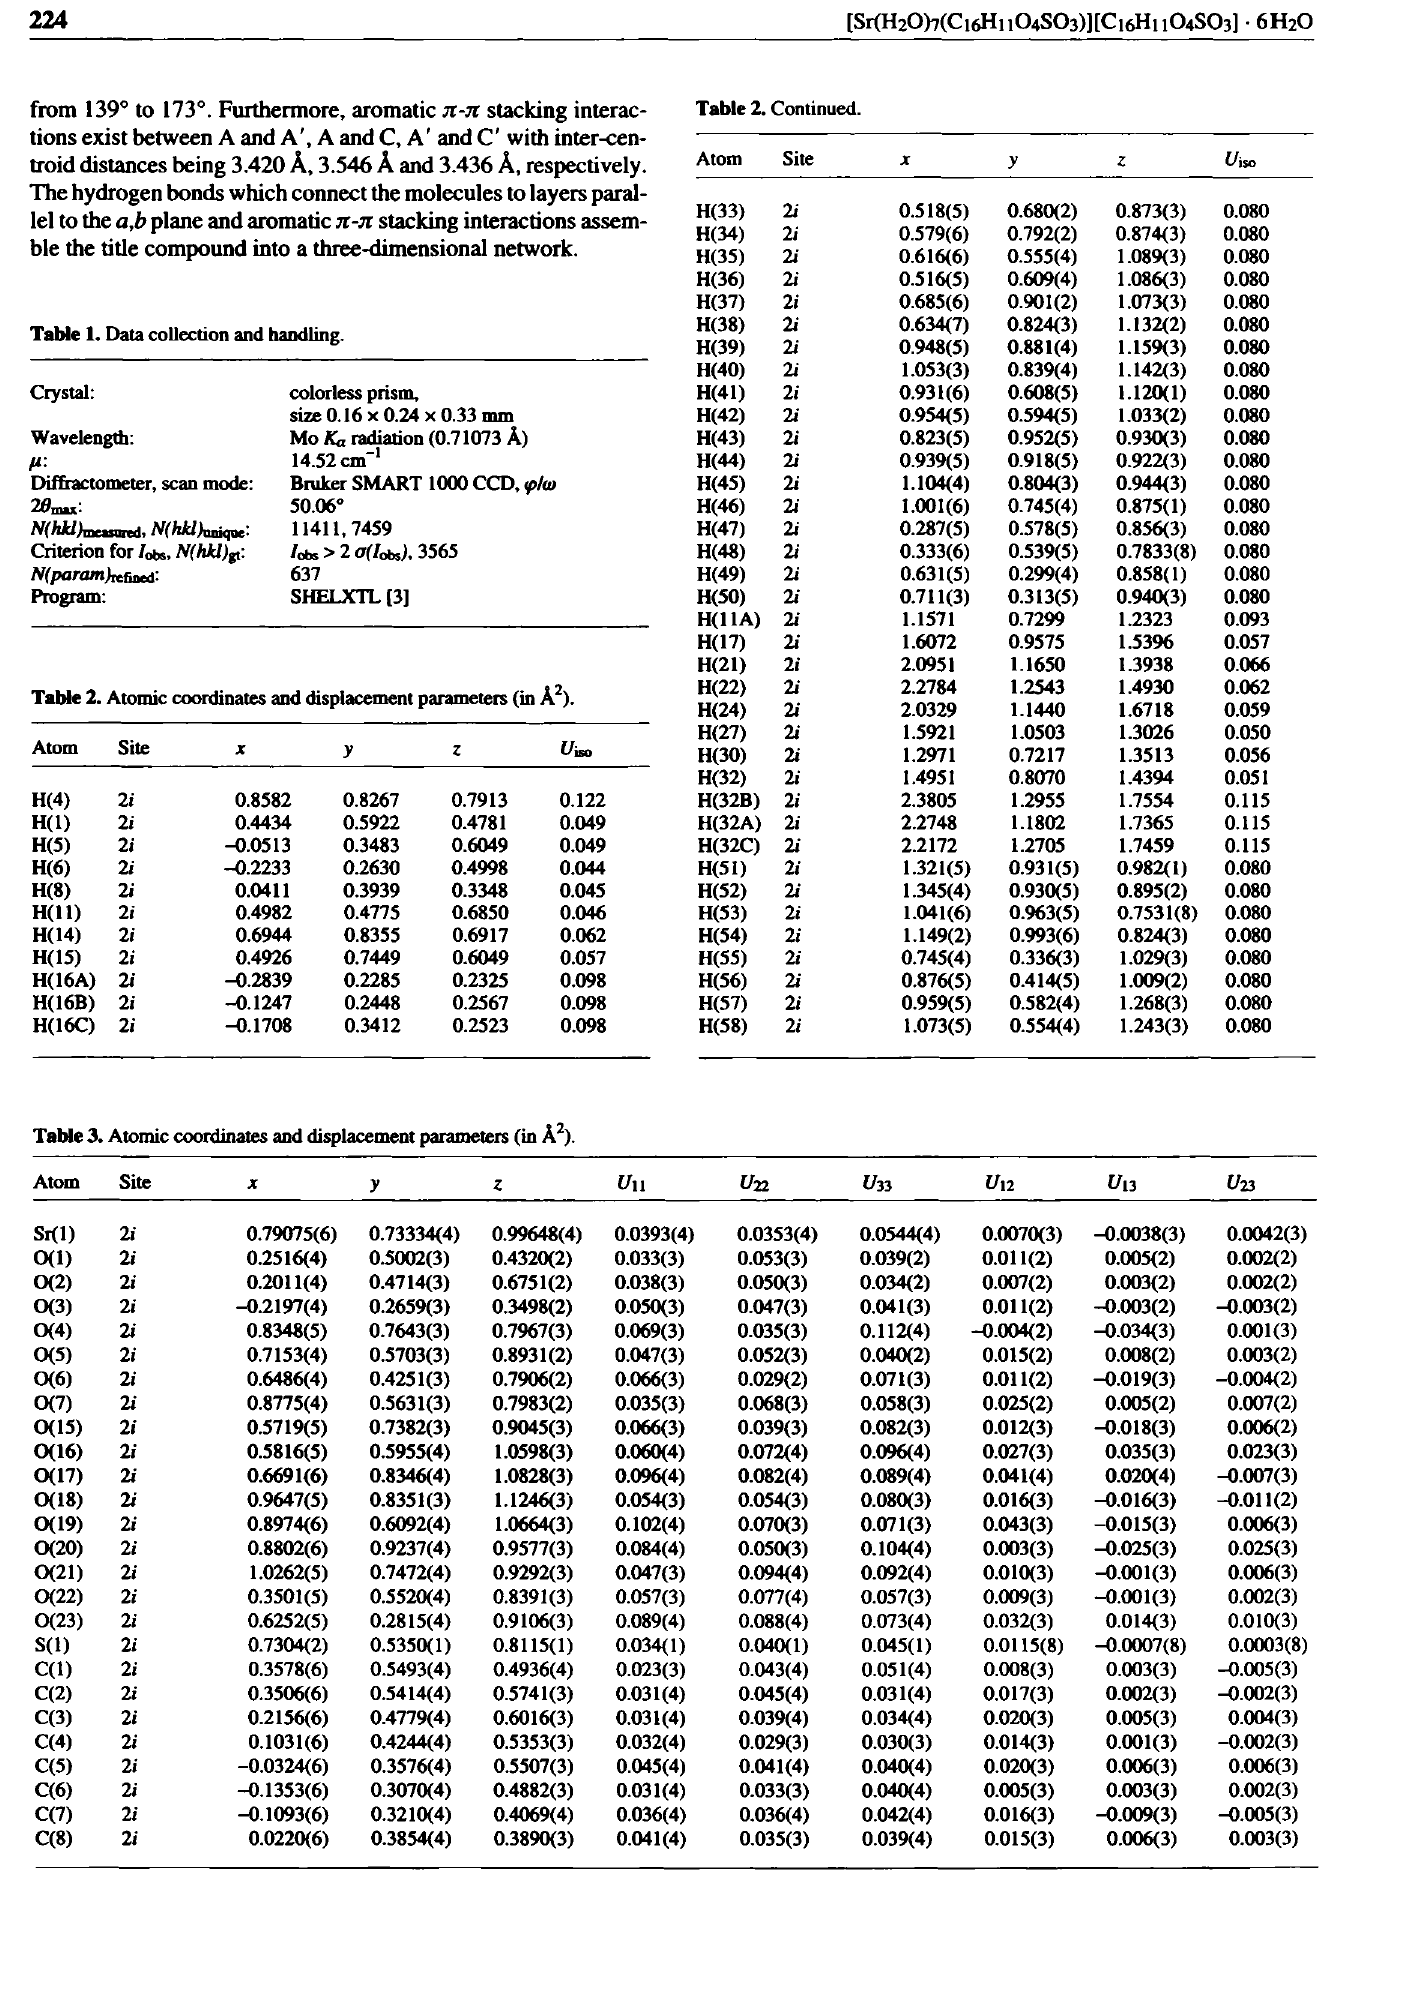
Table 2. Atomic coordinates and displacement parameters (in A 2 ).